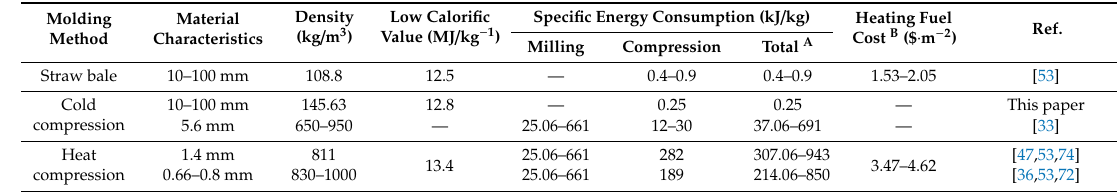
Table 8. The burning characteristics, forming energy consumption, and use costs compared among di ff erent forms of corn straws.